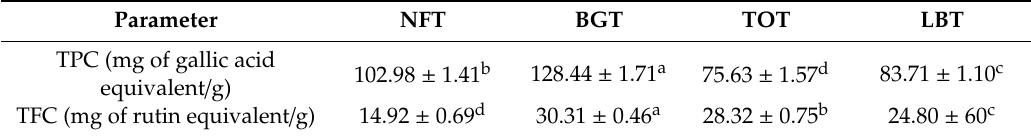
Table 3. Total phenolic and flavonoid contents of di ff erent tea